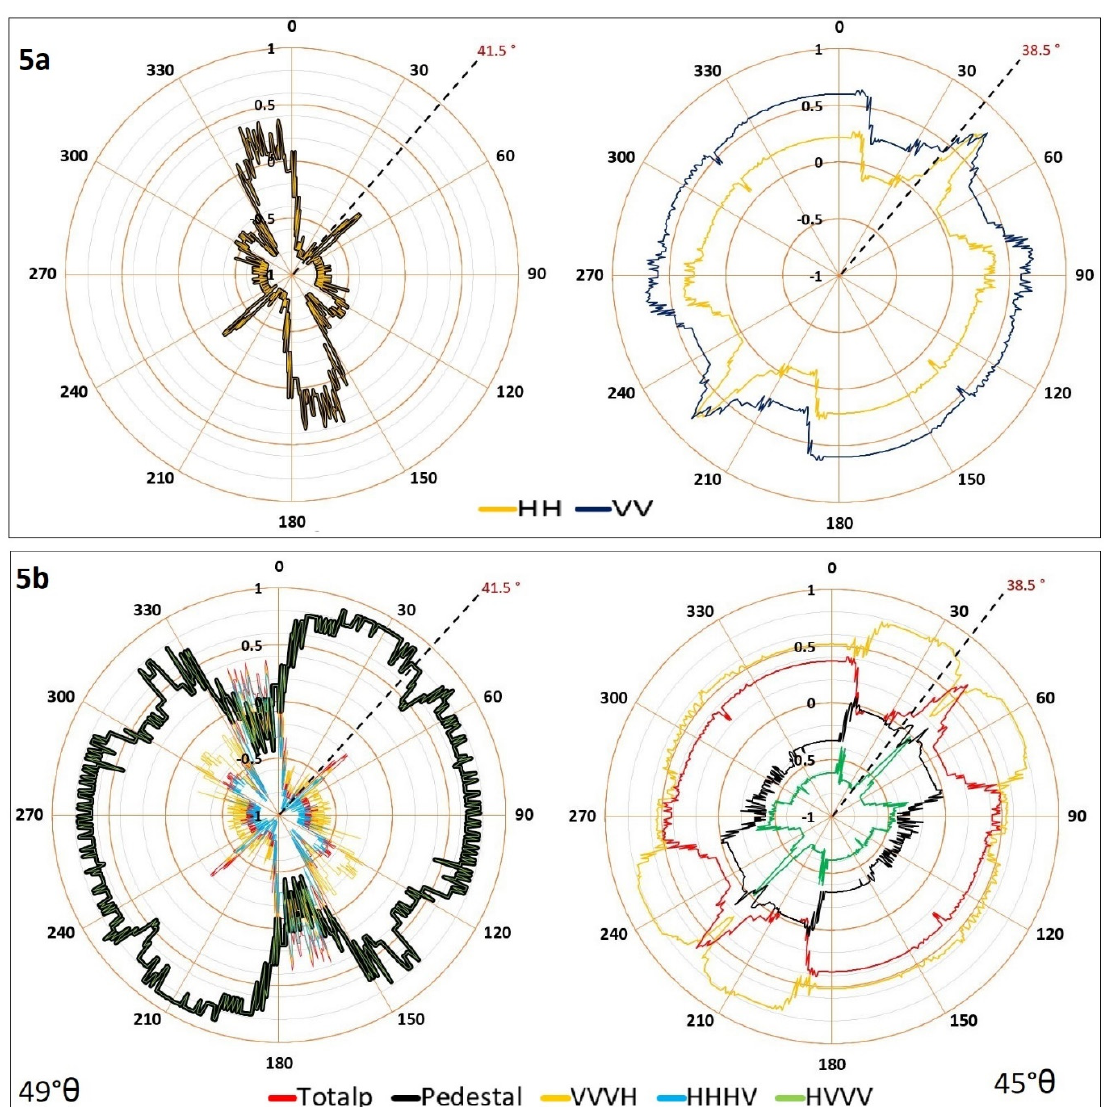
Figure 5. Sensitivity of RADARSAT-2 parameters with respect to the orientation of mean RMSH at incidence angle 45° and 49°, with look angles 38.5° and 41.5°, respectively. ( a ) The sensitivity of linear backscatter coefficients ( σ ° HH and σ ° VV) to the directionality of RMSH at incidence angles 45° and 49°. ( b ) The sensitivity of cross-polarized ratios (VV/VH, HH/HV, HV/VV), total power and pedestal height with respect to the RMSH orientation at both incidence angles.